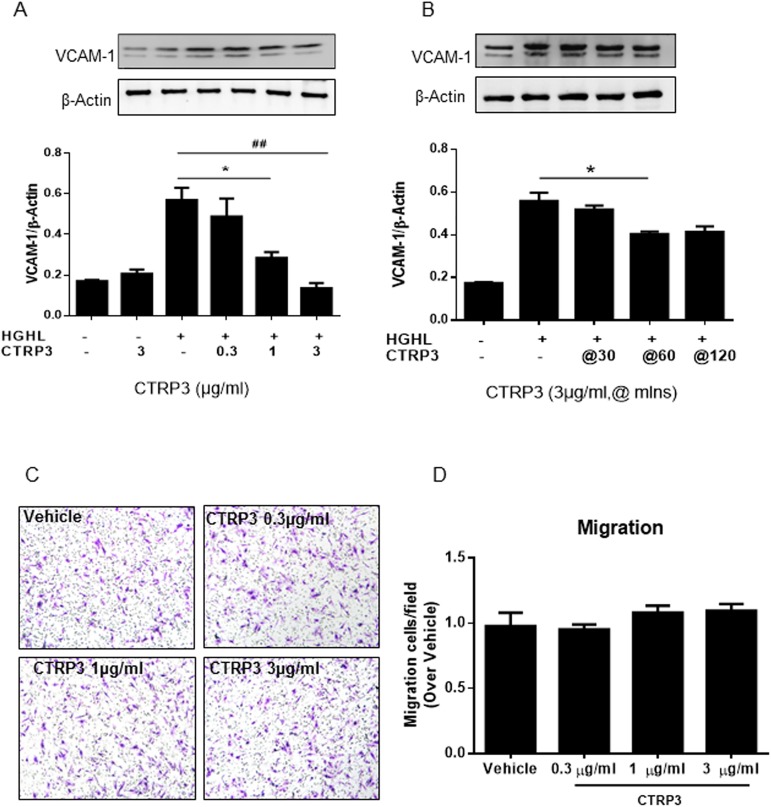
CTRP3 inhibits high glucose/high lipids (HGHL)-induced expression of VCAM-1 in a time- and dose-dependent manner.(A) HRMECs were subjected to high glucose/high lipid endothelial growth medium for 48 hours, incubated with CTRP3 (0.3, 1, 3μg/mL) for 60 minutes. VCAM-1 was inhibited in a concentration-dependent manner. (B) HRMECs were subjected to various periods of CTRP3 treatment (30, 60, and 120 minutes). VCAM-1 significantly decreased after 15 minutes, with decreasing trend for 120 total minutes. (C) HRMECs were placed in transwell migration chambers containing filters coated with matrigel. To stimulate migration, different concentrations of CTRP3 (0, 0.3, 1, 3μg/ml) were added to the lower chamber. Transwell chambers were stained with crystal violet and imaged after 8 hours. (D) The average number of migrated cells was quantified compared to vehicle control. Results are expressed as means±SD from 5–6 independent experiments. Each experiment was repeated 3 times. *, P<0.05; ##, P<0.01 vs respective control.